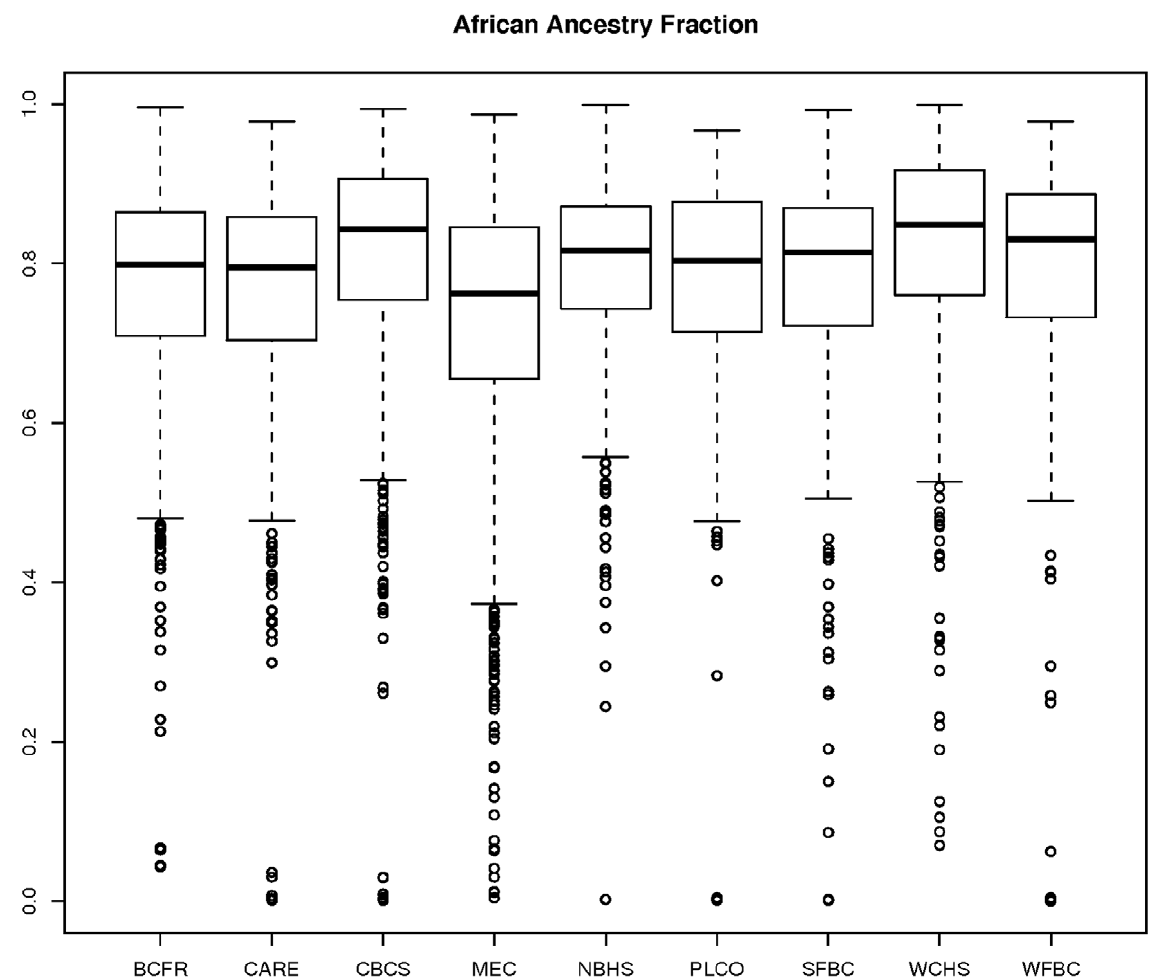
Figure 4. Plot of estimate of proportion of African ancestry from STRUCTURE by participating AABC study.